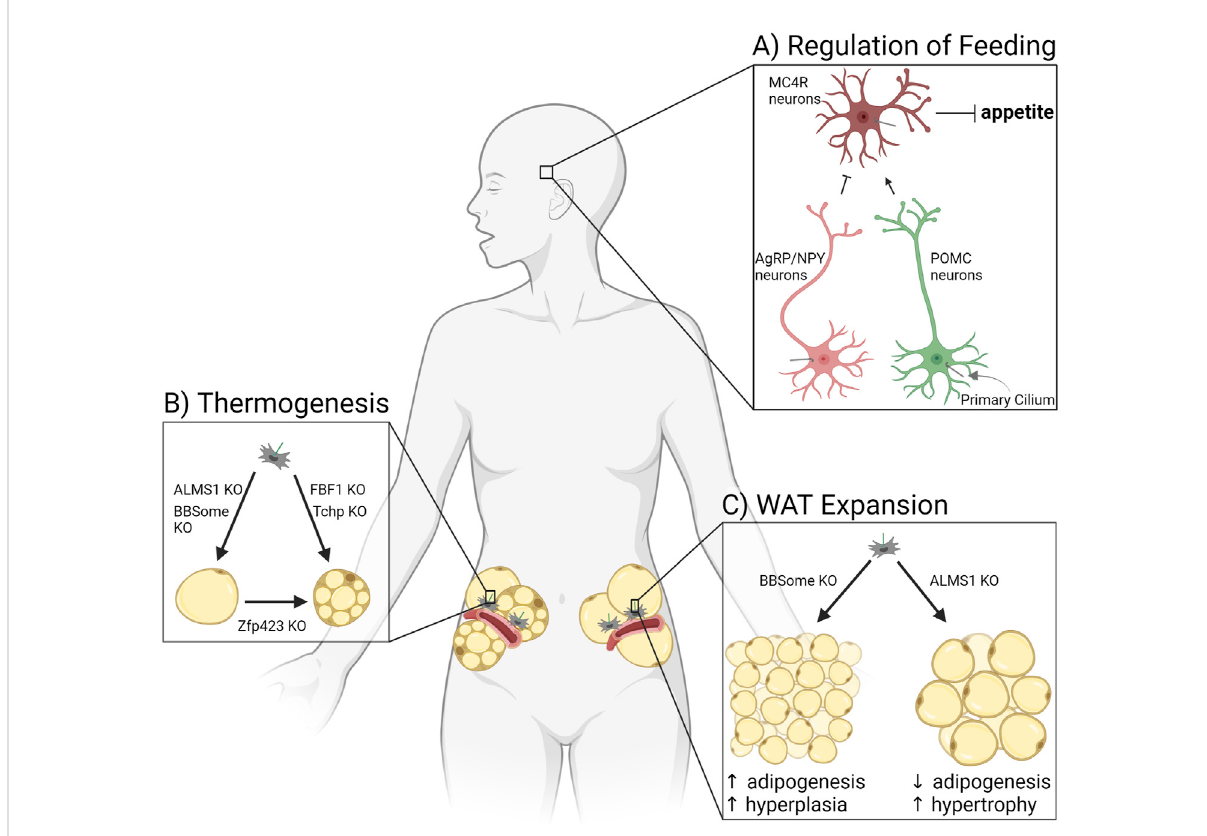
FIGURE 3 Ciliary signaling regulates adipose tissue. (A) Primary cilia of three types of neurons in the hypothalamus regulate appetite, thereby controlling adiposity due to hyperphagia. (B) Adipocyte potential for thermogenesis in white adipose tissue is affected by ciliary protein knockouts (KO). (C) Expansionofwhiteadiposetissuethroughadipogenesisiscontrolledbyciliarysignalingpathwaysalteredinpatientsandmicede fi cientfortheBBSome or